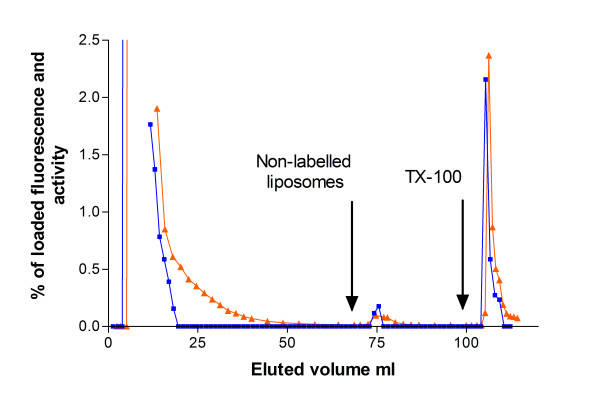
Elution of retained labeled liposomes with Rhod-PE and AChE by passing non-labeled liposomes. Liposomes, labeled with rhod-PE (fluorescence represented with red triangles, ) and containing AChE (activity represented with blue squares, ) were chromatographied on G25M. Fractions of 1.5 mL were collected. The first arrow indicates the injection of unlabeled liposomes on the column and the second arrow indicates the injection of 0.5% TX-100 on the top of the columns.